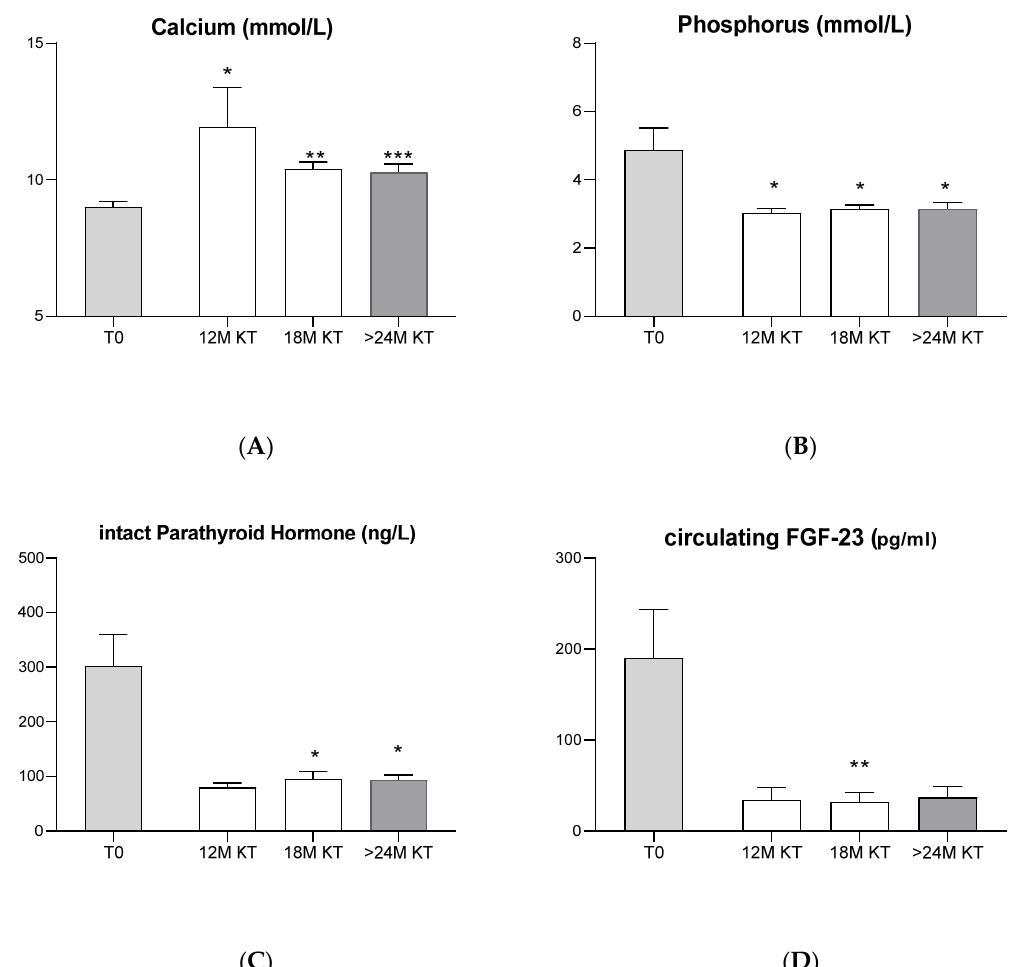
Figure 3. Serum levels of calcium ( A ), phosphorus ( B ), iPTH ( C ) and circulating levels of FGF-23 ( D ) at baseline (T0 before KT n = 13) and 12 ( n = 6), 18 ( n = 10) and 24 months ( n = 6) after kidney transplantation. * p < 0.05, ** p < 0.01 and *** p < 0.001, each time after TX (12, 18 and 24M) versus baseline (T0).